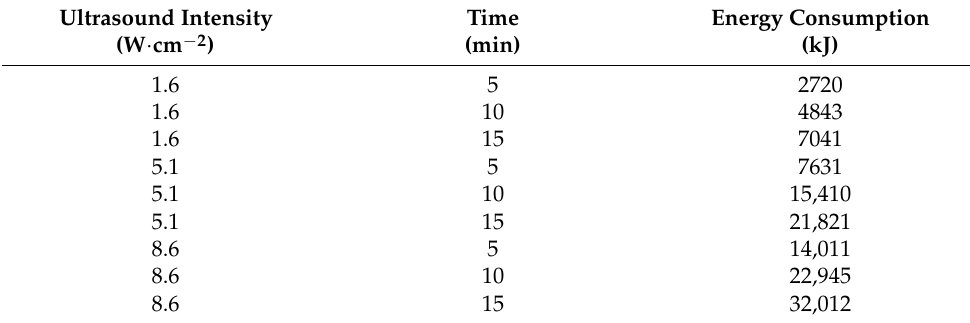
Table 7. The energy emitted by the ultrasonic device during extraction. Ultrasound